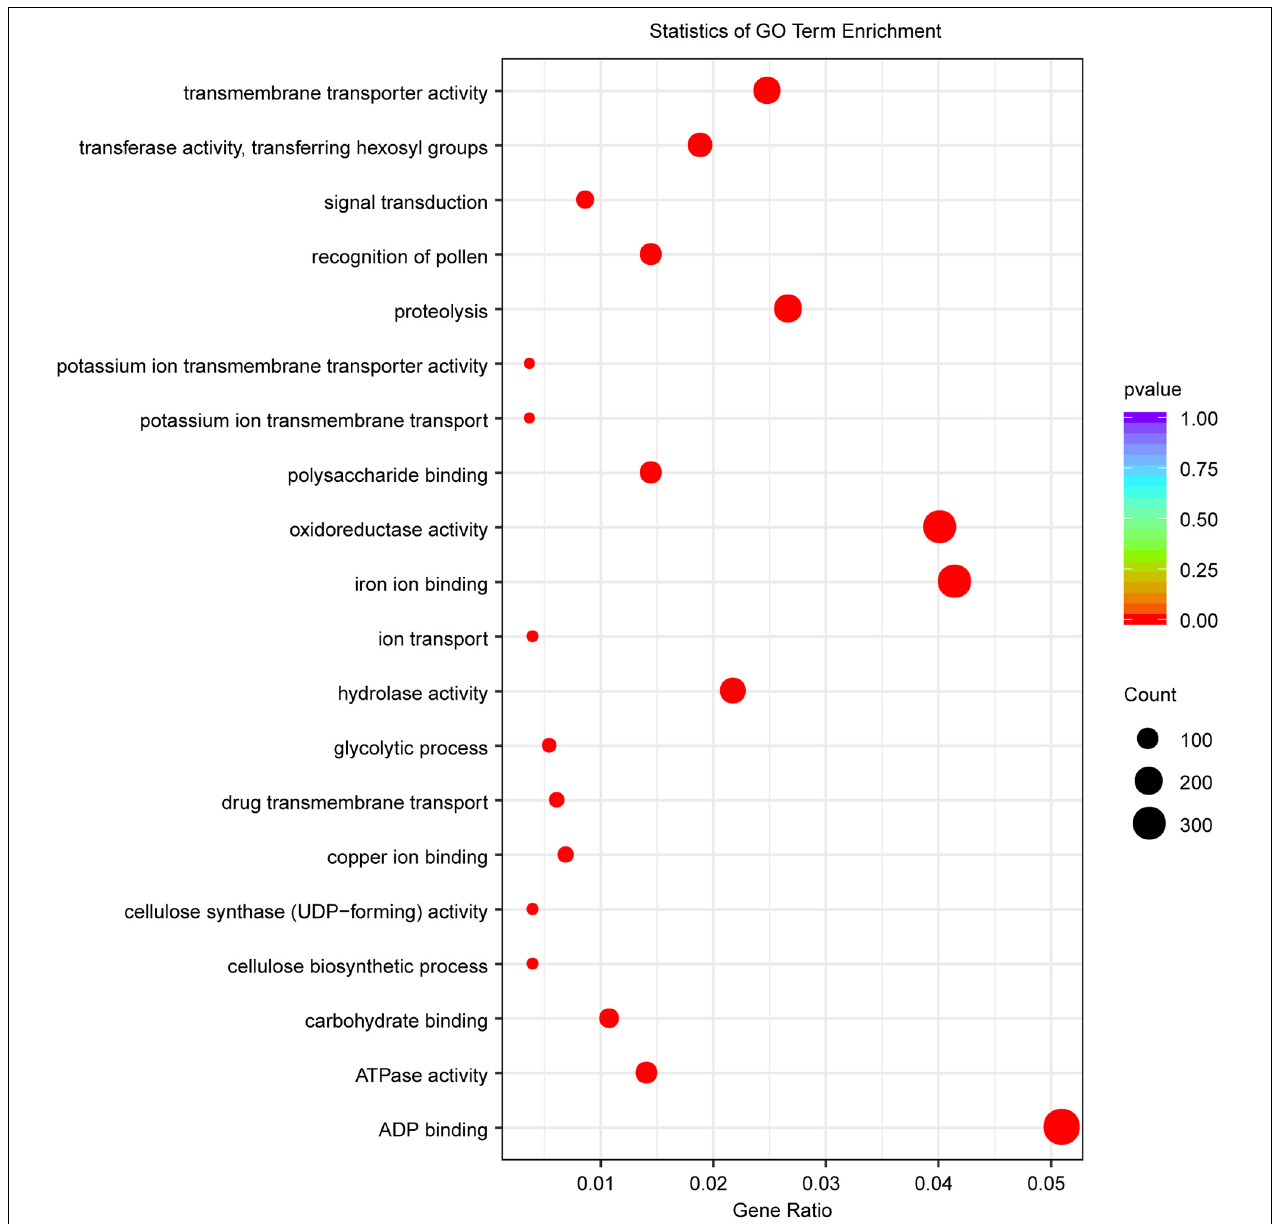
FIGURE 8 | Statistics of the GO enrichment analysis of the expanded gene families. The x -axis represents the percentage of enriched genes to the total annotated genes. The y -axis indicates the entry of each enrichment category. The size of the dots corresponds to the number of enriched genes, and the color panel on the right indicates the q -value. The lower the value, the more significant it